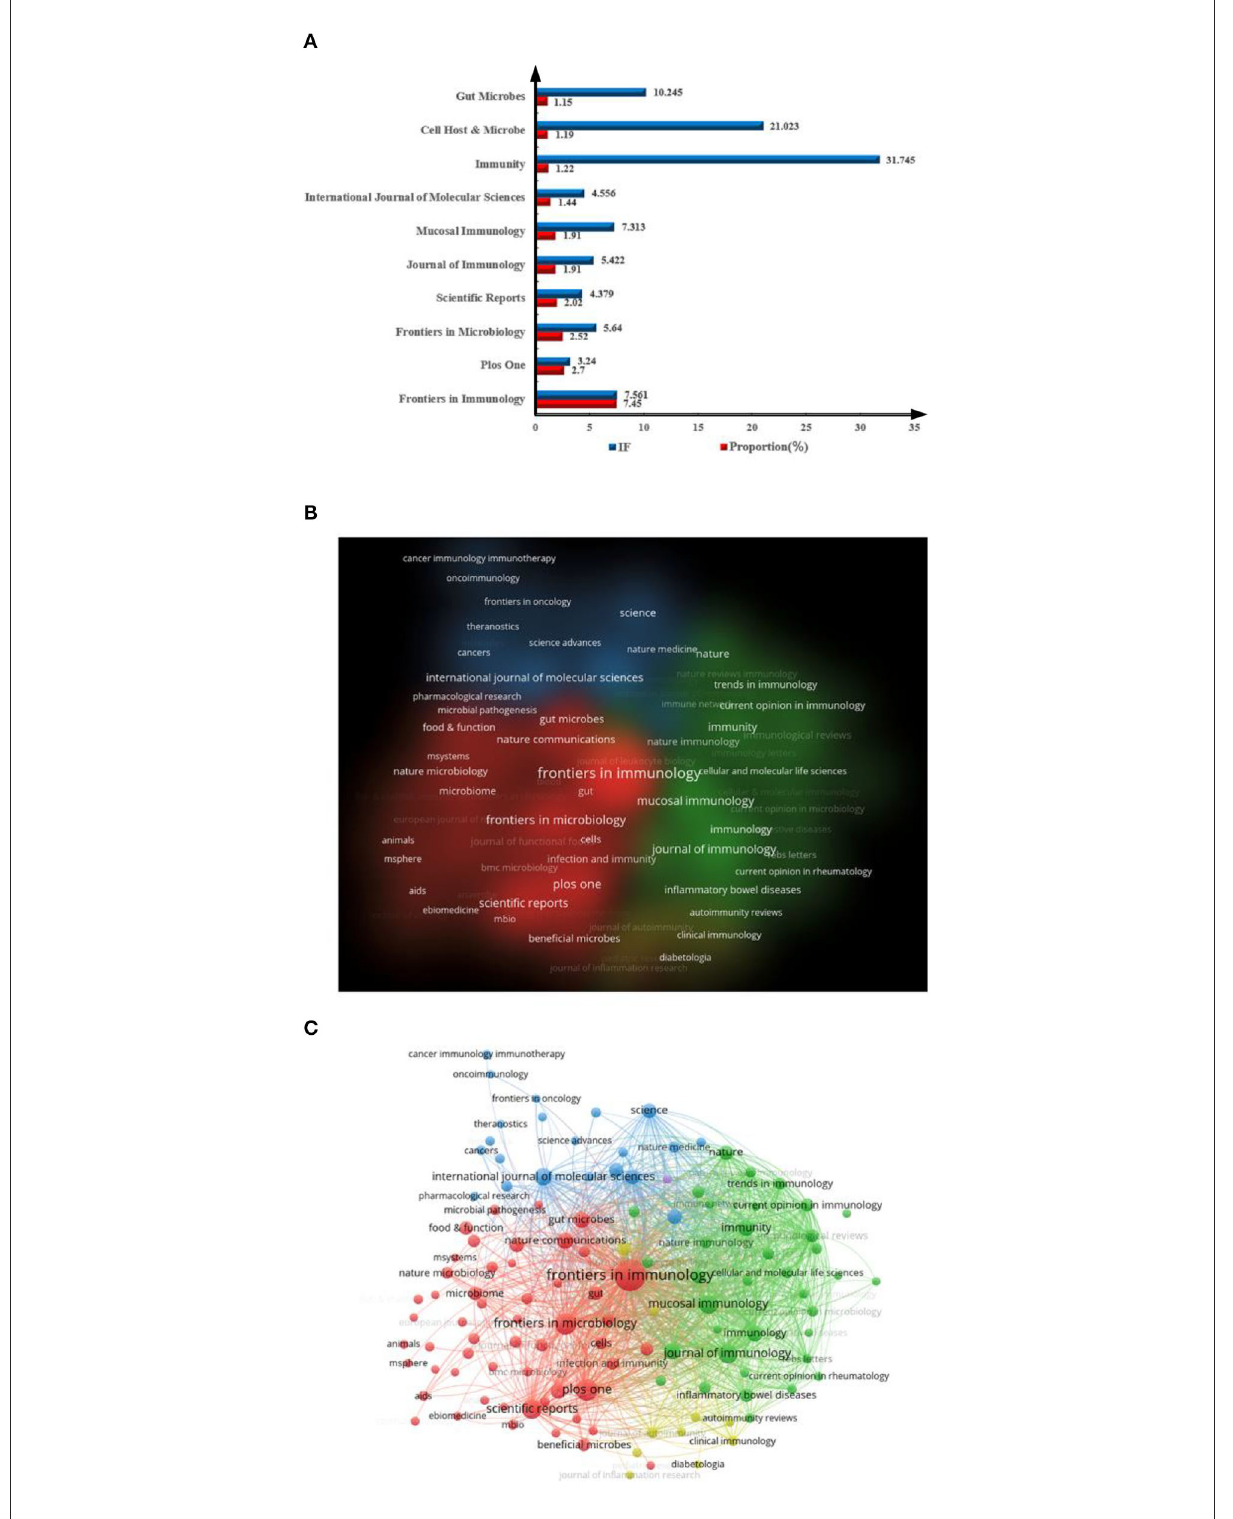
FIGURE6 Distribution of journals engaged in research on gut microbiota and host immune response. (A) Top 10 journals by number of publications; the blue bar representing IF and red bar representing proportion. (B,C) Network of institutions visualized in VOSviewer; the size of circles reveals the